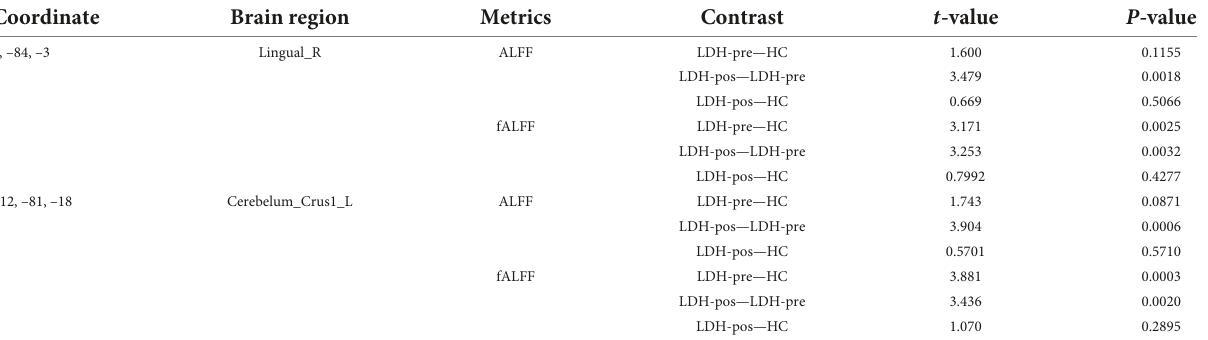
TABLE 4 Group differences in ALFF and fALFF in slow-4